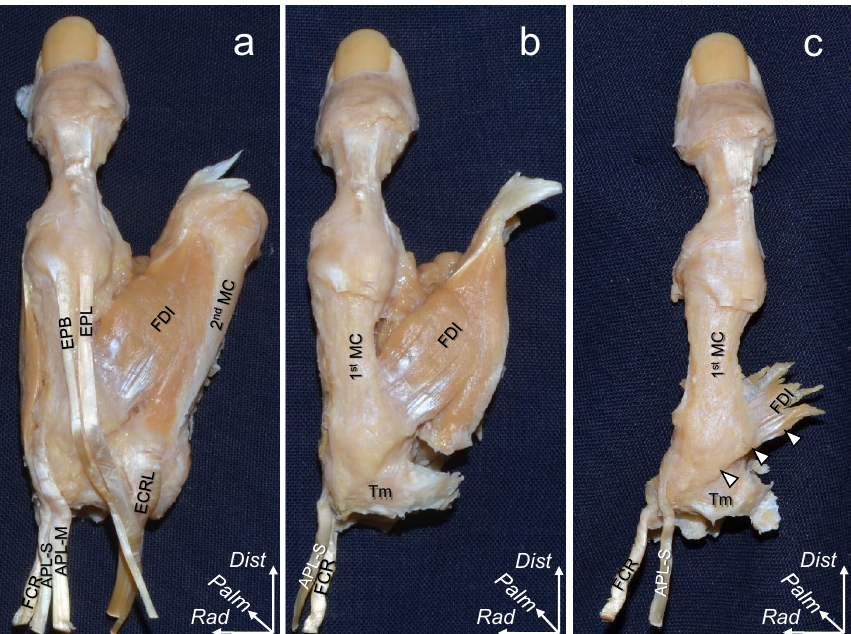
Figure 3. Macroscopic analysis of the dorsal aspect of the trapeziometacarpal joint. Photographs showing the layered relationships between the first dorsal interosseous (FDI) muscle and the joint capsule of the right thumb. ( a ) thumb and the second metacarpal bones (2nd MC) after removal of the skin and surrounding soft tissues. ( b ) the extensor pollicis brevis tendon (EPB), extensor pollicis longus tendon (EPL), extensor carpi radialis longus tendon (ECRL), 2nd MC, and abductor pollicis longus main tendon (APL-M) are removed from ( a ). ( c ): the muscular parts of the FDI are removed from ( b ), and the tendinous parts of the FDI and dorsal joint capsule (white arrowheads) are shown. APL-S, abductor pollicis longus–supernumerary tendon; FCR, flexor carpi radialis; Tm, trapezium; Dist , distal; Rad , radial; Palm ,